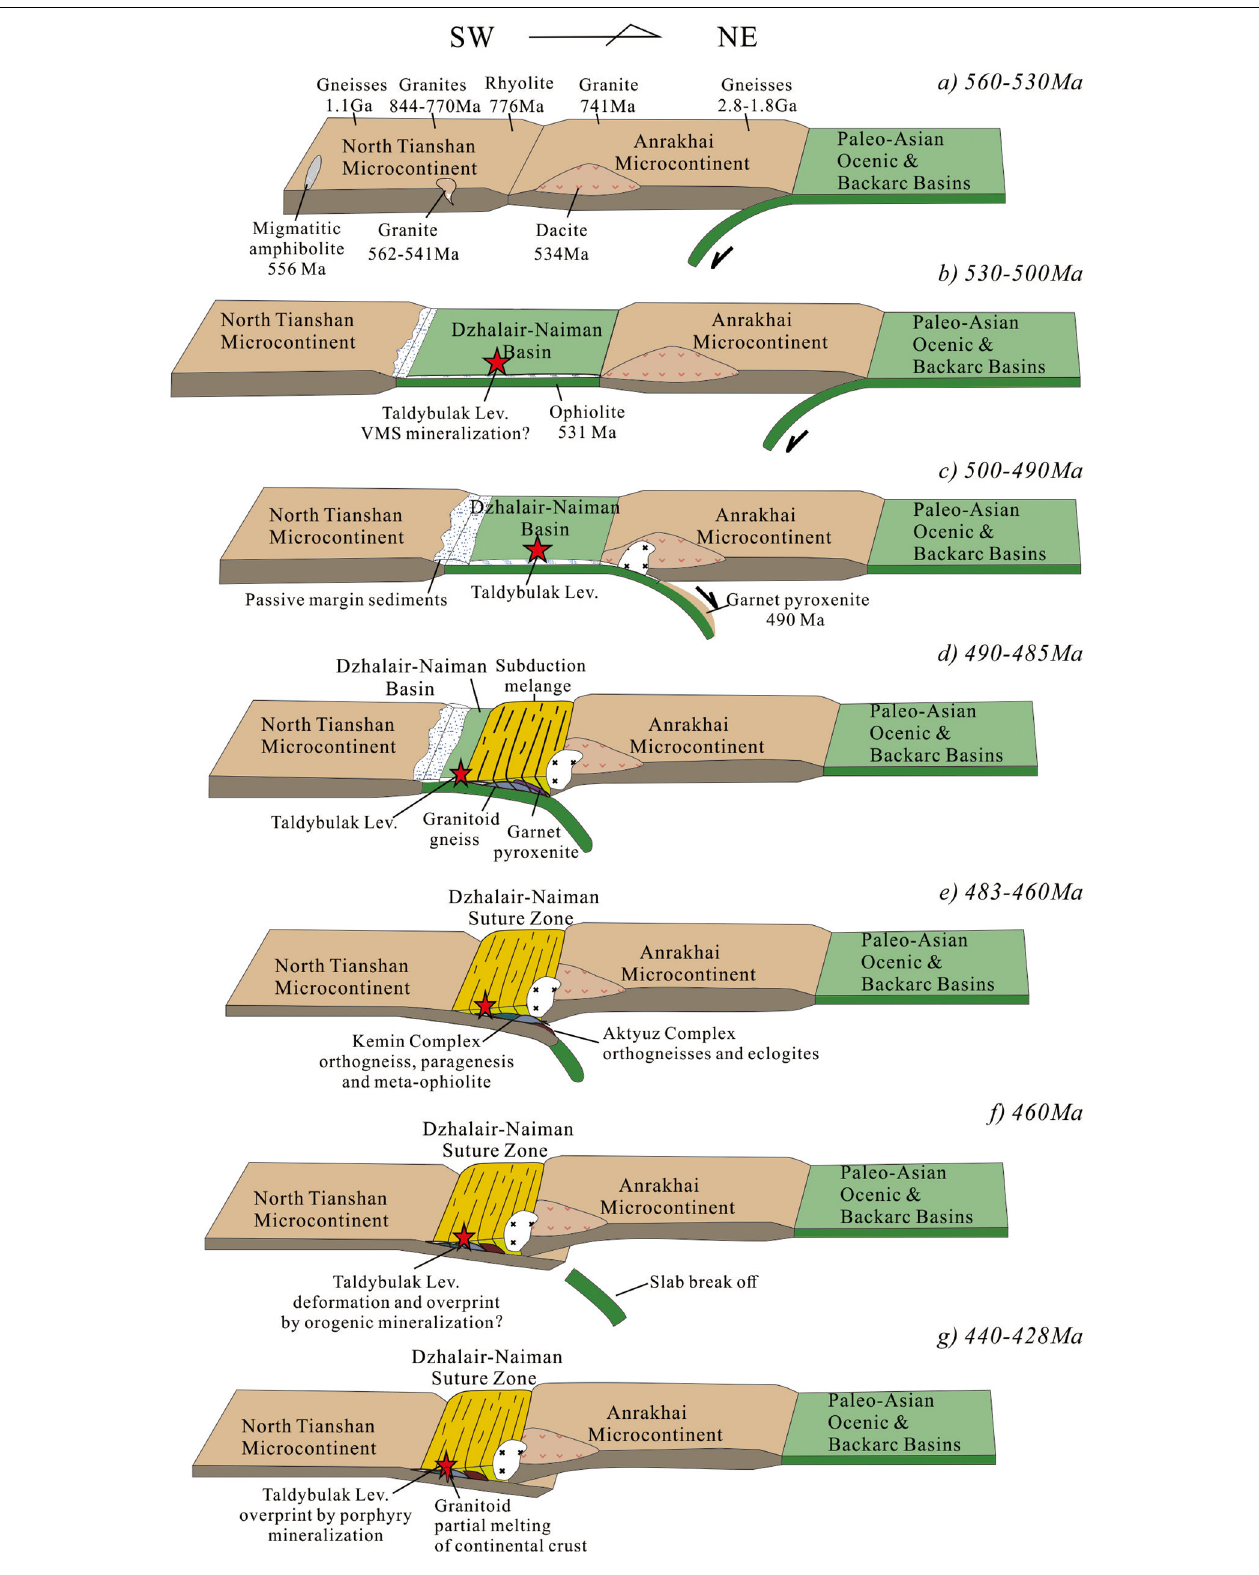
FIGURE 9 | Tectonic evolution of the Aktyuz Terrane and the fate of the Taldybulak Levoberezhny deposit (modified from Kröner et al., 2012).